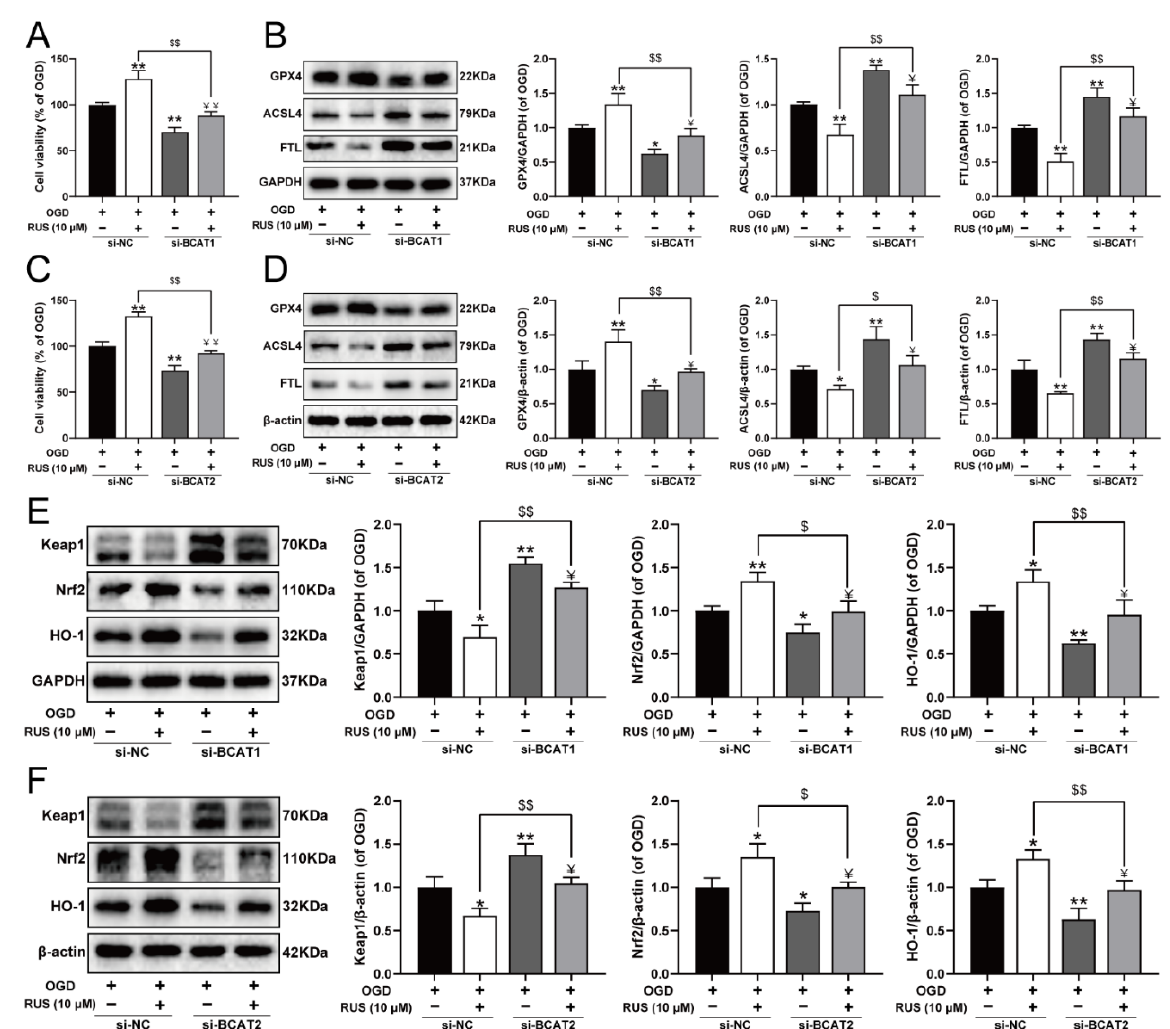
Figure 8. BCAT1 or BCAT2 knockdown partially weakened the protective effect of RUS in OGD-injured H9c2 cardiomyocytes. ( A ) The cell viability of H9c2 cardiomyocytes after being transfected with BCAT1 siRNA ( n = 6). ( B ) Western blotting analysis of GPX4, ACSL4, and FTL in H9c2 cardiomyocytes transfected with BCAT1 siRNA ( n = 3). ( C ) The cell viability of H9c2 cardiomyocytes after being transfected with BCAT2 siRNA ( n = 6). ( D ) Western blotting analysis of GPX4, ACSL4, and FTL in H9c2 cardiomyocytes transfected with BCAT2 siRNA ( n = 3). Western blotting analysis of Keap1, Nrf2 and HO-1 in H9c2 cardiomyocytes transfected with ( E ) BCAT1 siRNA or ( F ) BCAT2 siRNA ( n = 3). Results were expressed as mean ± SD. * p < 0.05, ** p < 0.01 vs. the OGD group, $ p < 0.05, $$ p < 0.01 vs. the group treated with RUS and OGD, Ұ p < 0.05, ҰҰ p < 0.01 vs. the group treated with OGD and BCAT1 siRNA or BCAT2